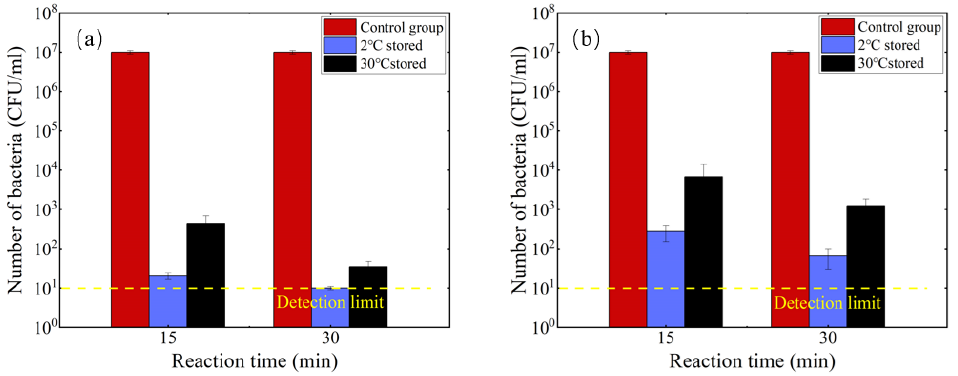
Figure 11. PATW disinfection effect after storage for ( a ) 6 h, ( b ) 24